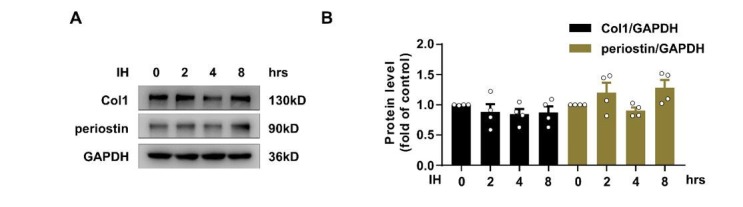
Effect of Intermittent hypoxia (IH) on the expression of collagan I and periostin.(A) Expression of TSP1, collagen I (Col1) and periostin in mPCFs exposed to IH for the indicated time detected by western blot analysis. (B) Quantification of TSP1, Col1 and periostin in (A). Data are mean ± SEM, n=4 independent experiments, *P<0.05, 1-way ANOVA with Bonferroni post-test.